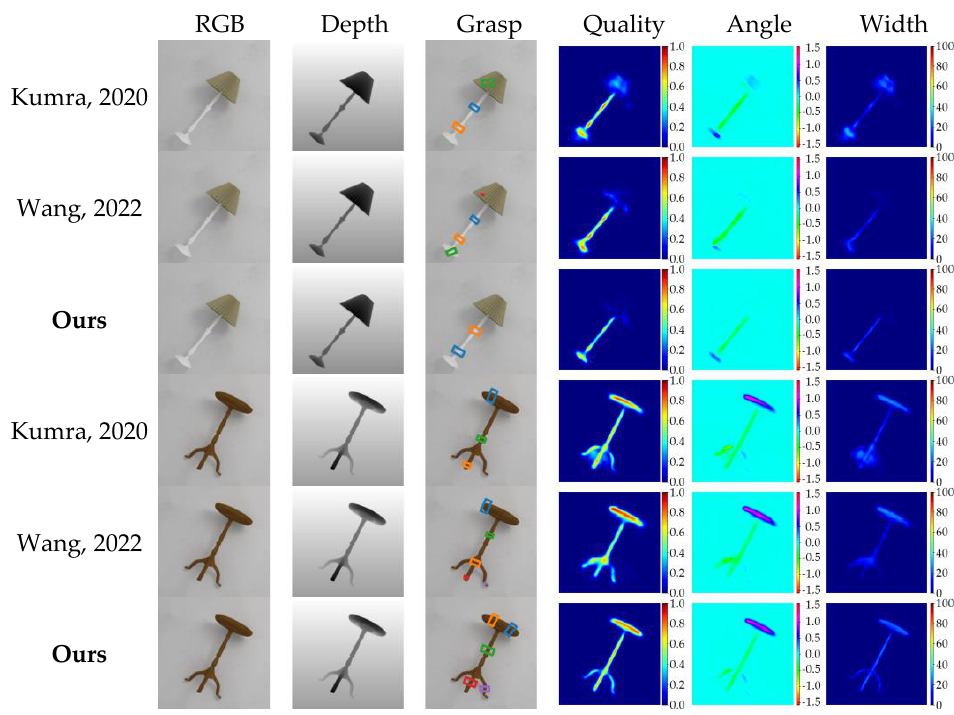
Figure 12. Experiment results of algorithms proposed by Kumra et al. [8] in 2020, Wang et al. [6] in 2022 and our method on Jacquard dataset.